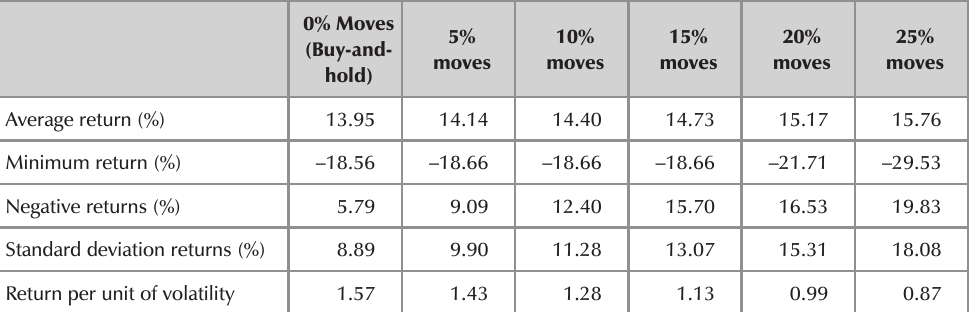
Asset allocation strategies based on IAPE quintiles (1996-2006)